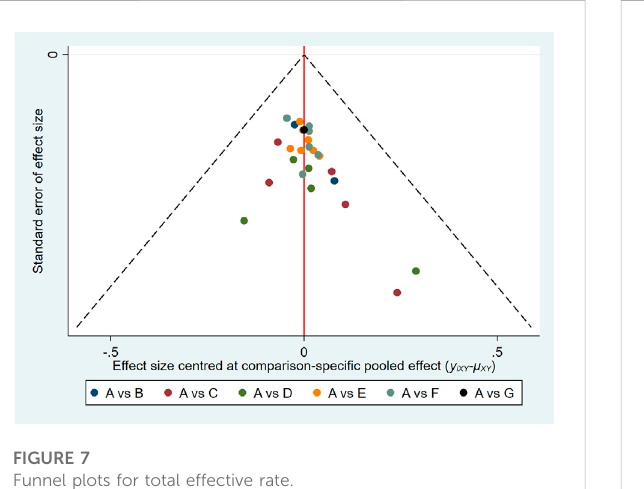
FIGURE 8 Funnel plots for